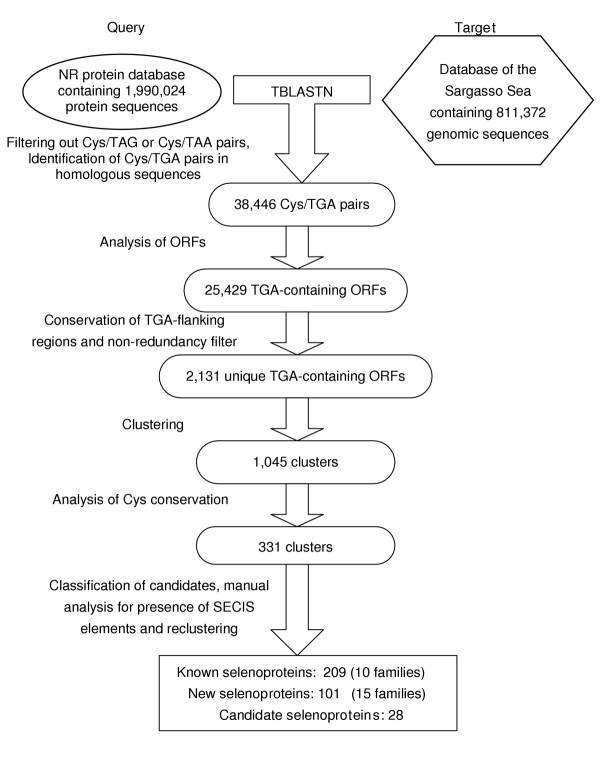
A schematic diagram of the search algorithm. Details of the search process are provided in Materials and methods and are discussed in the text.